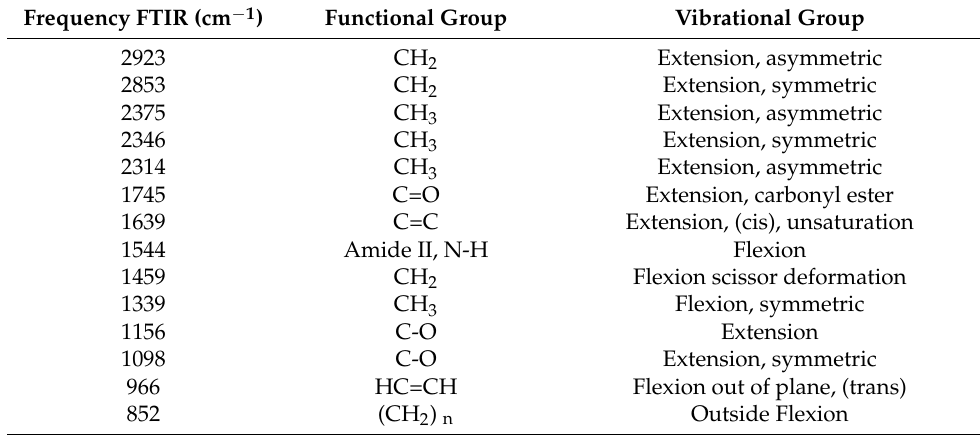
Figure A2. FTIR of sample AA-75T-25M. Table A2. Analysis of FTIR result for sample